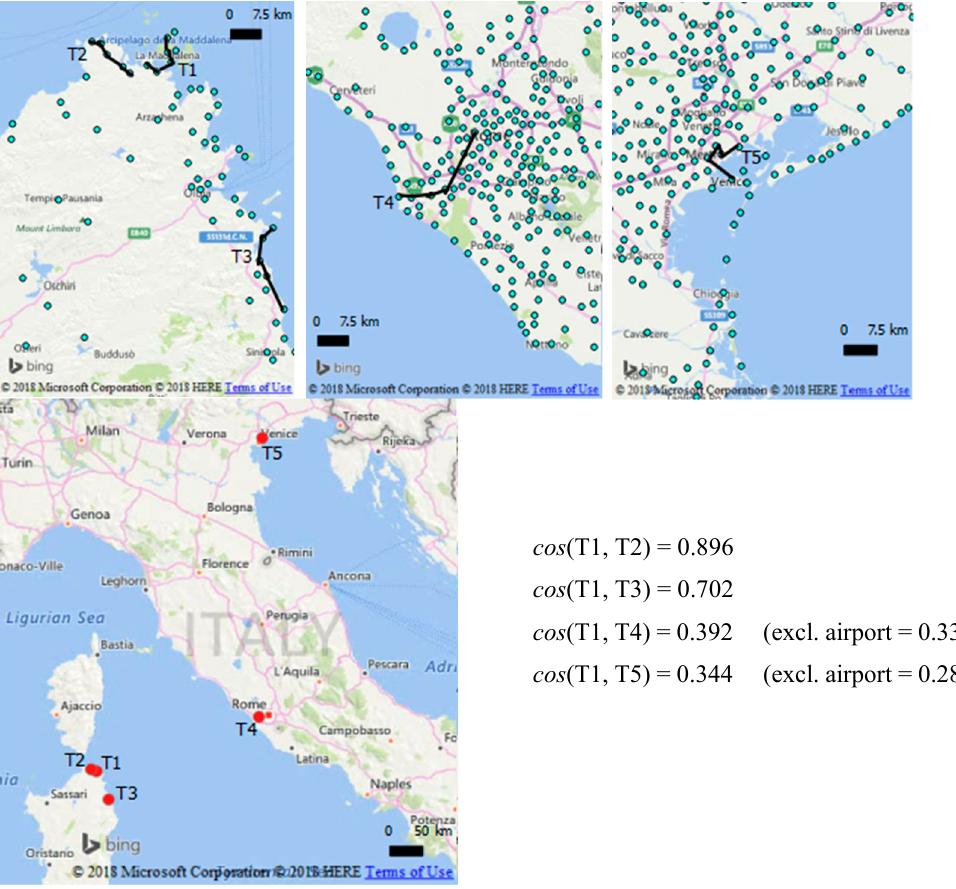
Figure 13. Similarity comparison between five traces distributed over a wide territory. Each of T4 and T5 comprises an airport location in the composition: similarities in brackets are reported excluding those airport locations from the traces.